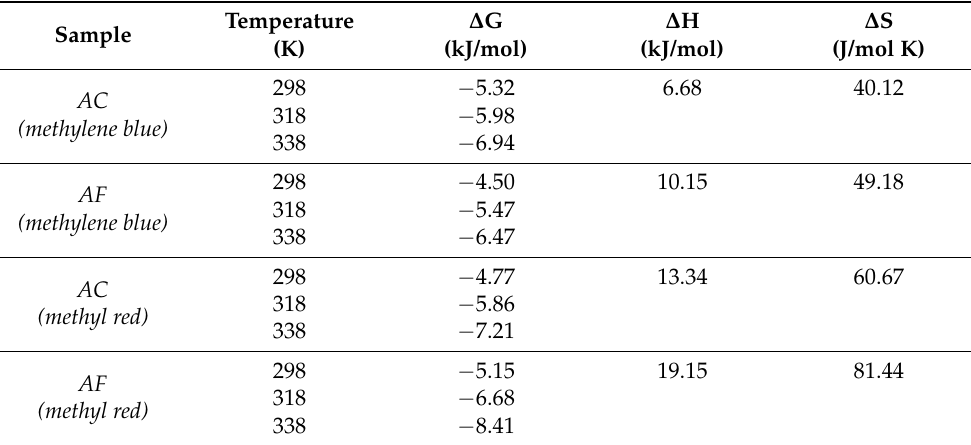
Figure 6. Effect of temperature on the adsorption of methylene blue ( a )/methyl red ( b ) on activated carbon.